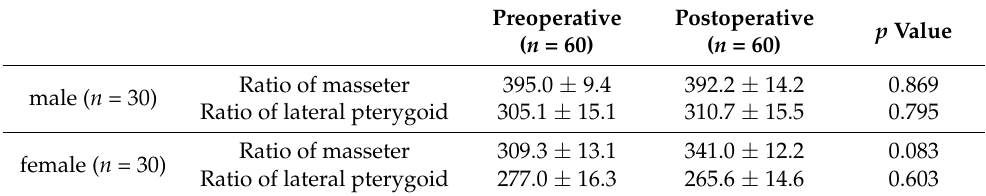
Table 3. Changes in volume-to-length ratios after a mandibular setback according to